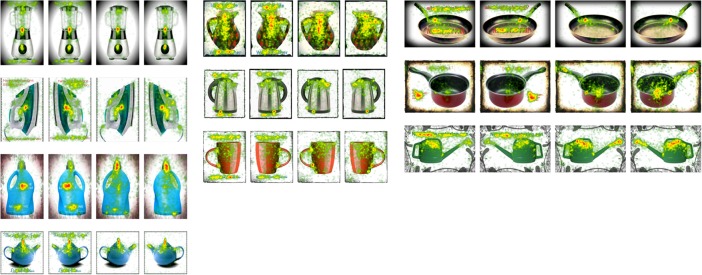
Heat maps depicting those areas of each advertisement that were fixated most often.All participants viewed both left- and right-handled objects and the heat maps show data collapsed across right- and left-handed participants. Red/green/yellow areas indicate where areas of the advertisements that were scanned by participants. Colours represent fixation frequency, progressing from red (most) to yellow to green (least). These colours clearly illustrate how the text on the advertisements influenced scanning patterns.